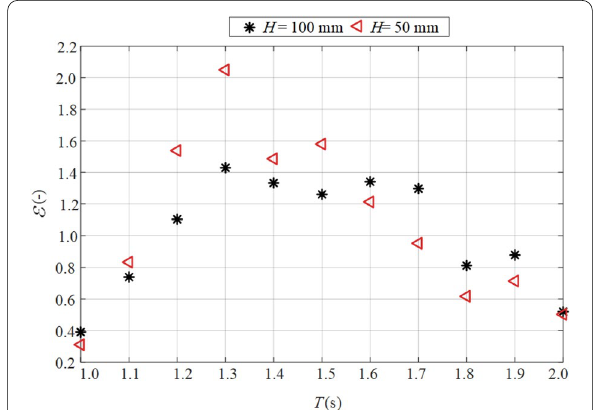
Figure 9 Effect of wave height on the total capture width ratio ( ε ) of the MC-OWC device for different wave periods at a constant device draught d 250 mm and an opening ratio R 2 =